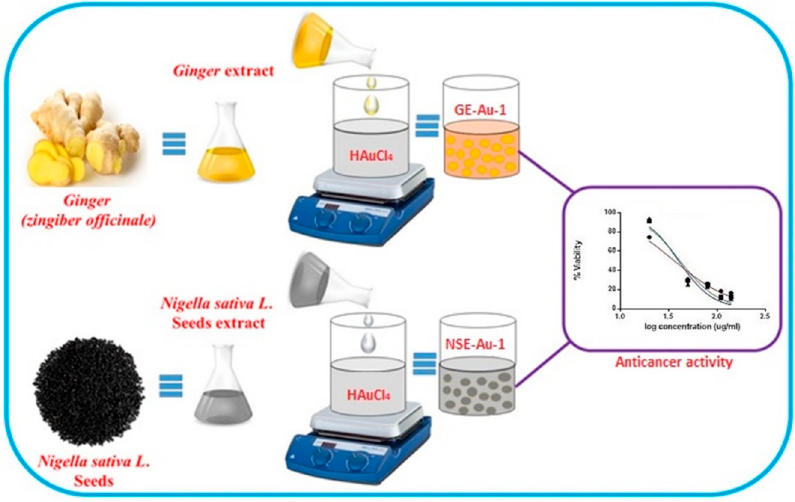
Scheme 1. Graphical representation of gold nanoparticles prepared using NSE extract and (b) GE